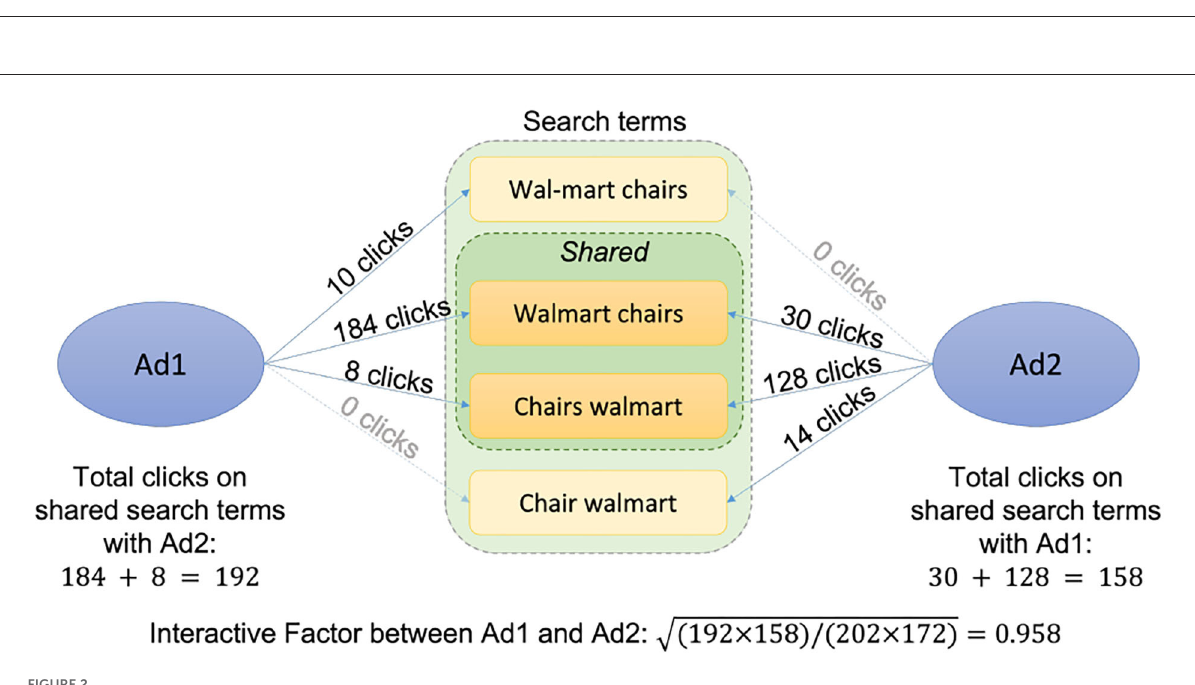
FIGURE2 Interactive metric: An example.